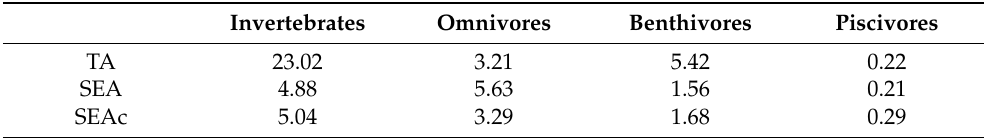
Figure 7. Isotopic niche width of functional feeding groups present in the sea adjacent to Miaodao Archipelago. Solid lines enclose the standard ellipse area (SEA), representing the isotopic niche of consumers. Dotted lines are the total area (TA) of the convex hulls representing the total niche width of the different consumers. Table 4. Summary statistics of SIBER analysis for each